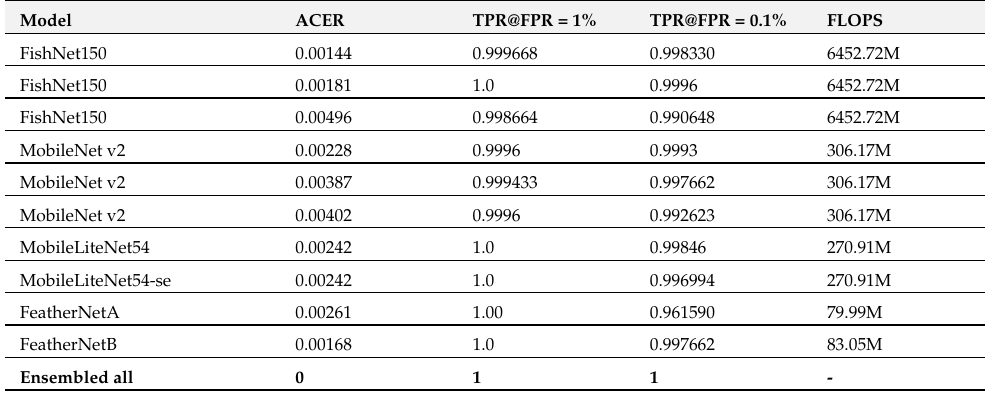
Table 5. Test Results of Liveness Detection